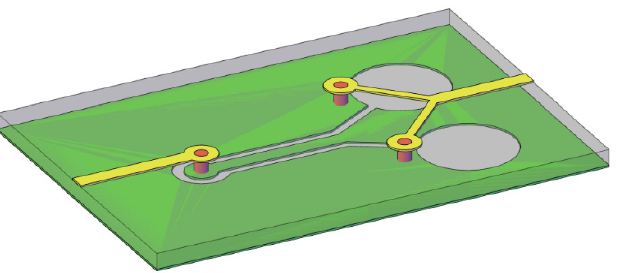
Figure 1. Perspective view of the proposed ultra-wideband (UWB) phase inverter consisting of a series of microstrip-coplanar waveguide (CPW)-slot transitions.